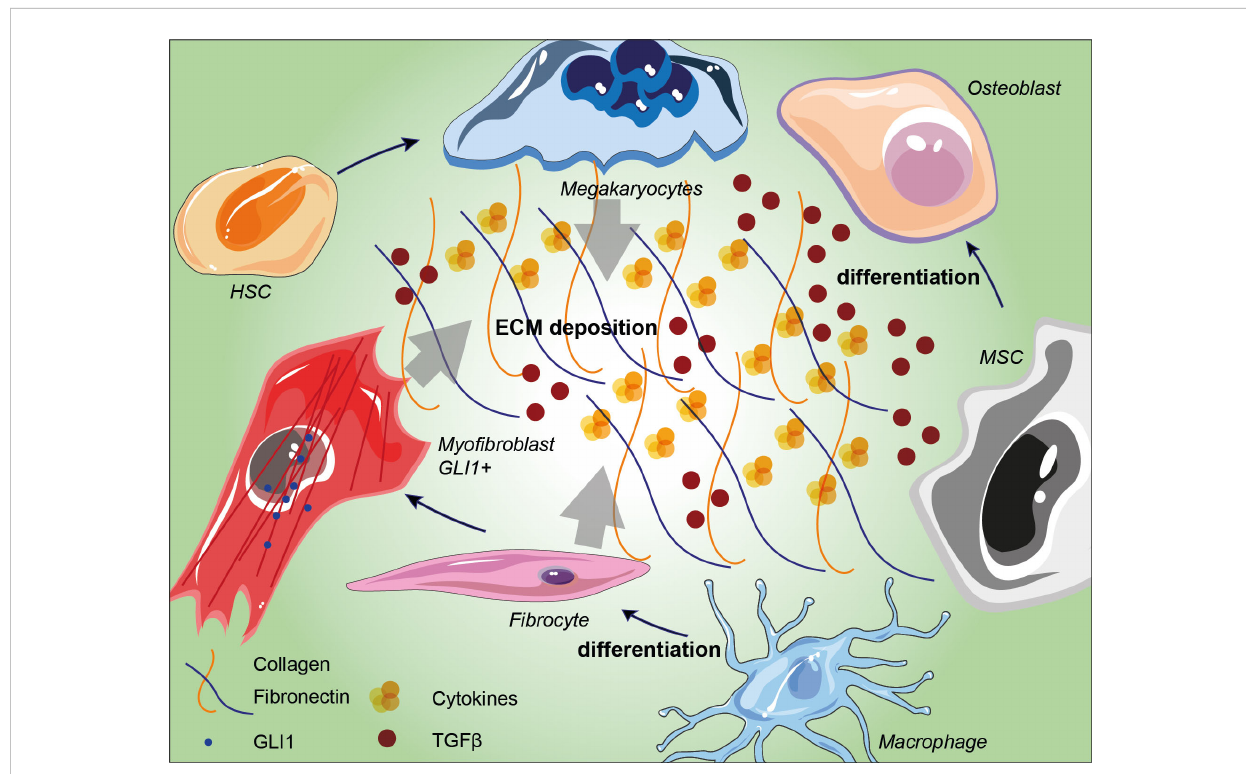
FIGURE 1 Schematic representation of BM niche fi brosis-driving cell populations and their involvement in extracellular matrix deposition. Arrows indicate the in fl uence of megakaryocytes, fi brocytes and GLI1 + myo fi broblasts in conditioning ECM in BM niches. TGF- b accumulation induces MSC differentiation into osteoblast and its overall accumulation within the ECM induces ROS production and bone remodeling. HSC: hematopoietic stem cell; MSC: mesenchymal stromal cell; ECM: extracellular matrix; TGF- b : transforming growth